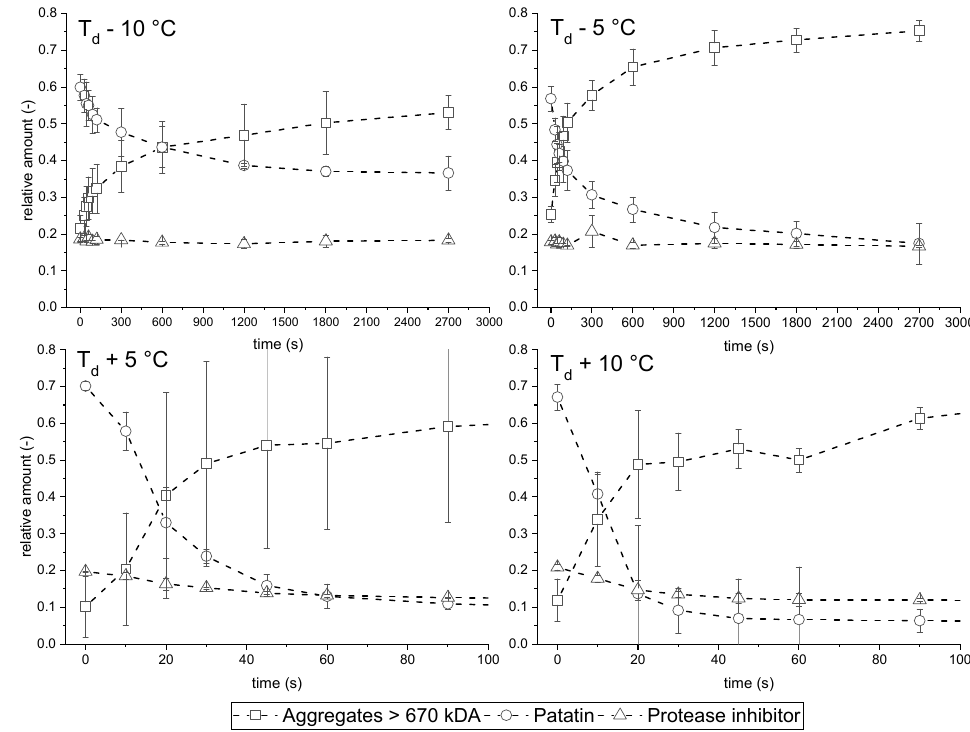
Figure 1. Change of absorbance area measured by SEC of the different protein fractions, exemplarily shown for a 1% PPI pH 7 solution after heating for different durations. As denaturation above T d happens very fast, only the first 100 s of are depicted.